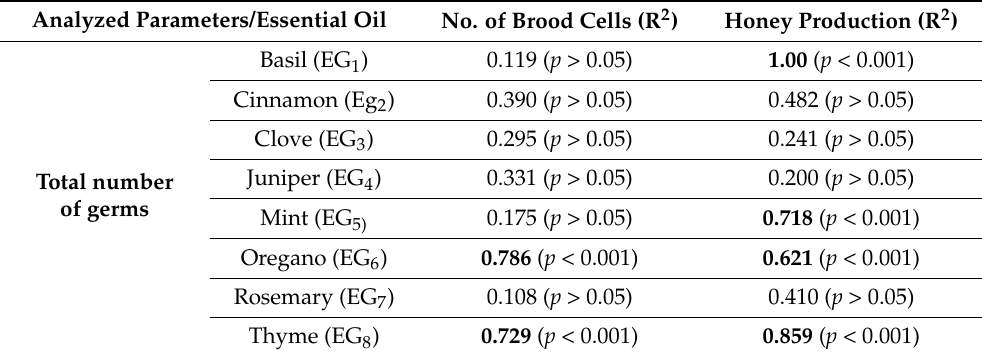
Table 2. Correlations between total worker bee gut germ counts, bee colony development, and rapeseed honey production following sugar syrup and essential oil feedings. Analyzed Parameters/Essential